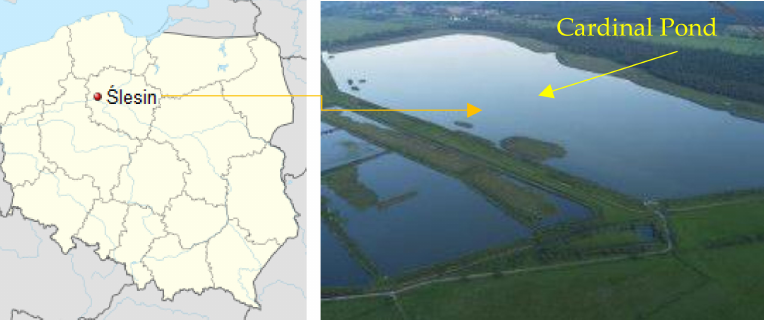
Figure 1. Location of the sampling area on the map of Poland and a view of Cardinal